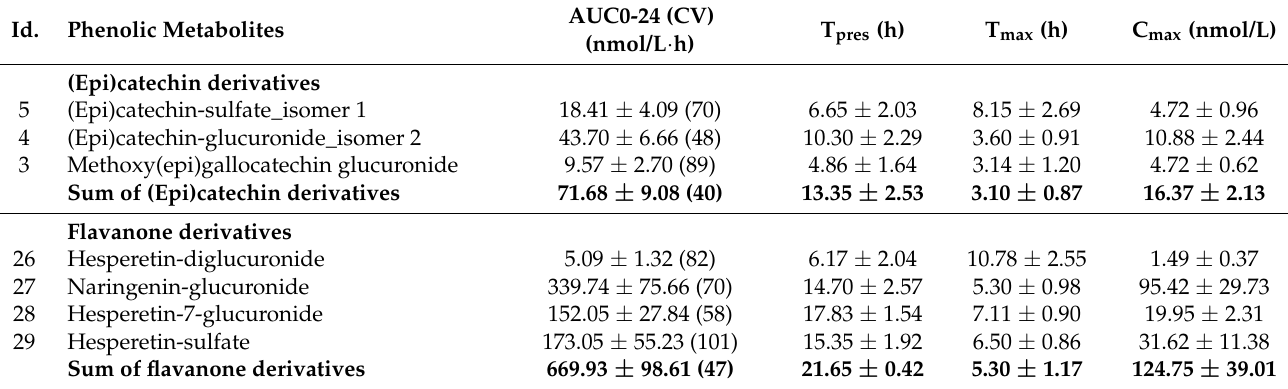
Table 4. Pharmacokinetic parameters of phenolic metabolites detected in plasma of the supplemented volunteers ( n = 10). Values are expressed as mean ± SEM. T max : time to reach the maximum plasma concentration; C max : maximum plasma concentration; AUC0-24: area under the curve; T pres : time of presence of metabolites in circulation (calculated by taking the time interval between the first appearance and the last appearance of the considered metabolite); CV: Coefficient of variation, expressed in